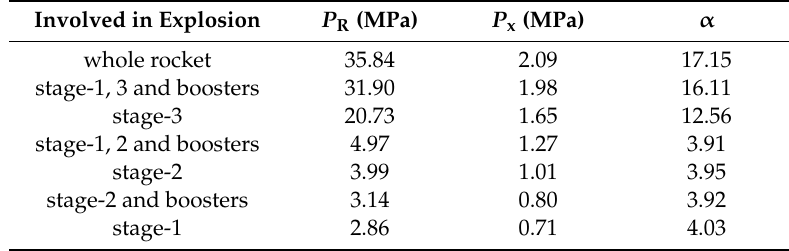
Table 12. Comparison of peak overpressures of the model with and without a rocket. Involved in